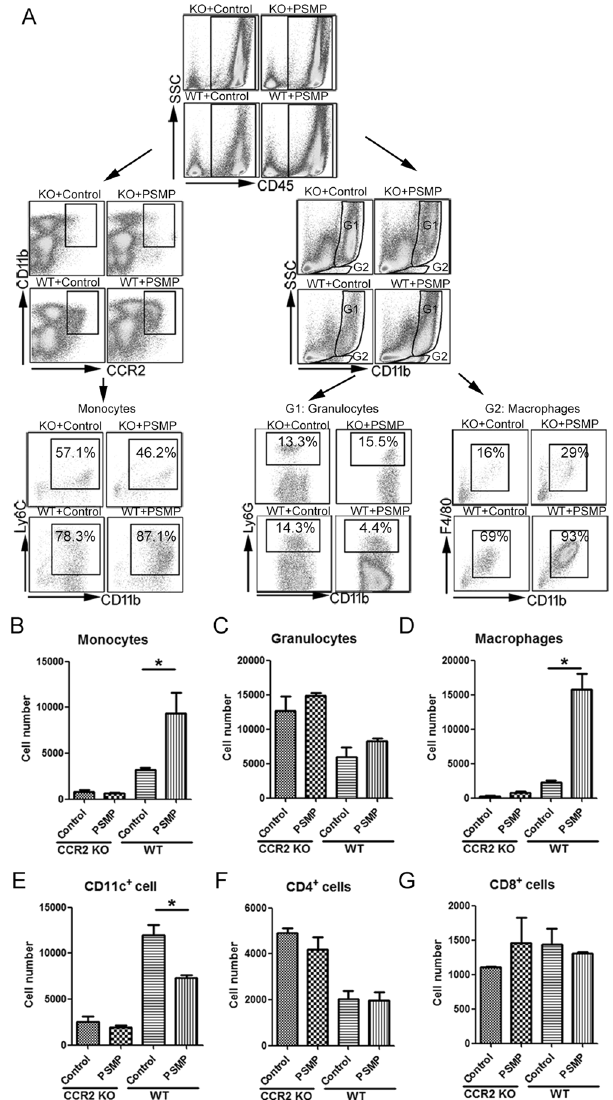
Figure 1. PSMP protein chemo-attracted the CCR2 + Ly6C hi monocytes into the abdominal cavity. ( A ) Forty- eight hours after the abdominal injection of PSMP protein, the main immune cells that were chemo-attracted by PSMP were analyzed by flow cytometry with the antibodies of CD45, CD11b, CCR2, Ly6C, Ly6G and F4/80. ( B – G ) The monocytes (CD11b + CCR2 + Ly6C hi ), granulocytes (G1&CD11b + Ly6G + ), macrophages (G2&CD11b + F4/80 + ), CD11c + cells, CD4 + cells and CD8 + cells in the abdominal cavities of the wild type and CCR2 KO mice intraperitoneally injected with and without PSMP were analyzed by flow cytometry system. Data were representative of at least two independent experiments with four mice per group. * 0.01 < p < 0.05, ** 0.001 < p < 0.01, and *** p <